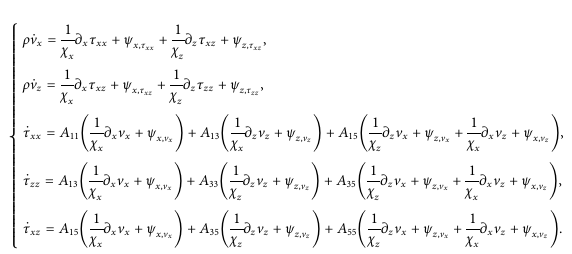
Frontiers in Earth Science |